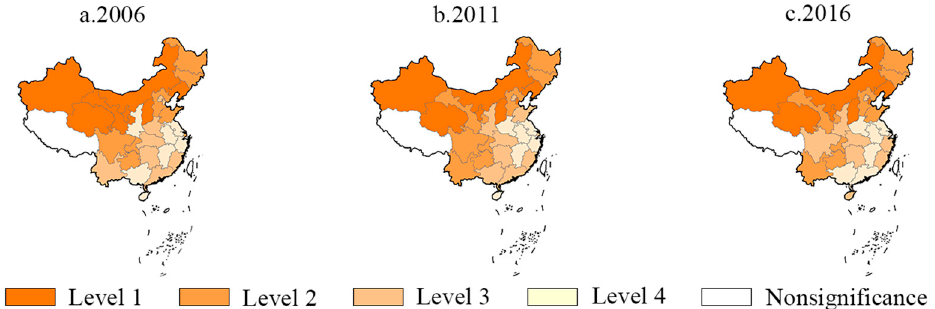
Figure 2. ( a ) Spatial distribution quartile maps of EIWB in 2006; ( b ) spatial distribution quartile maps of EIWB in 2011 and ( c ) spatial distribution quartile maps of EIWB in 2016. In spatial distribution maps above, shades of different regions reflect its grade of EIWB respectively. Darker color in a province indicates a higher grade of EIWB. In particular, blank areas are provinces with missing data. Except the blank areas, the provinces in China can be divided into four grades according to the color from dark to light. The first grade contains seven provinces with the highest EIWB in China, which are shown with the darkest colors in the figure. The second and third grades each include eight provinces. The remaining seven of the lightest areas are at the fourth grade.